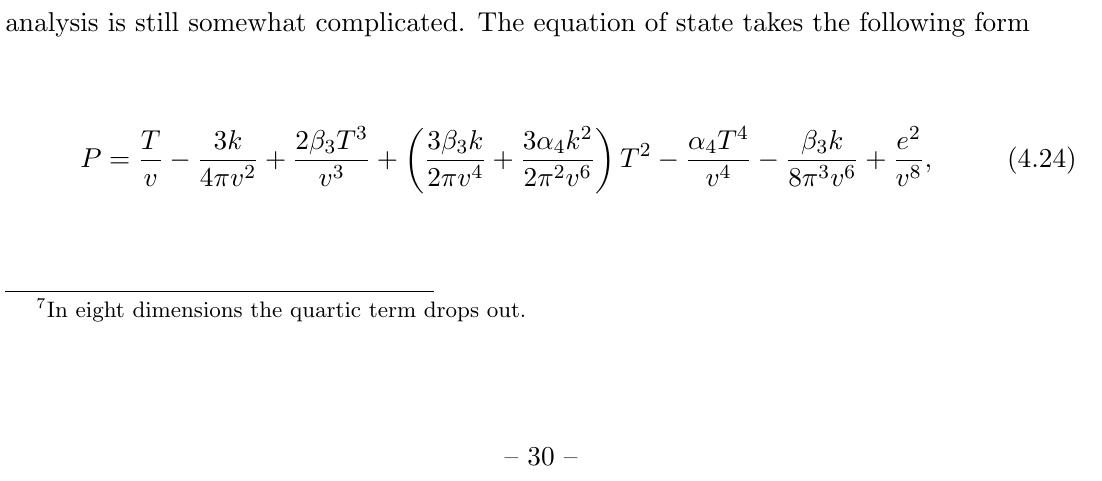
Figure 10 . Free energy as a function of temperature for d = 5 and k = (cid:0) 1 (color online). We set e 2 = 1 = 10, (cid:12) 3 = (cid:0) 4 e 2 and (cid:11) 4 = (cid:0) 6 e 3 , with dimensionless critical quantities T c and P c e (cid:25) 0 : 07772. Red lines correspond to negative speci(cid:12)c heat and green lines denote negative mass. Top left: a plot of the Gibbs free energy for P = 1 : 2 P c (dotted, black curve) and P = P c (solid, black and red and green curve). Top center : for P = 0 : 95 P c a reverse VdW phase transition occurs. Top right: P = 0 : 9 P c , Bottom left: P = 0 : 8 P c , Bottom center: P = 0 : 6 P c , Bottom right: P = 0 : 2 P c . The latter sequence shows that the swallowtail develops unphysical branches and then vanishes